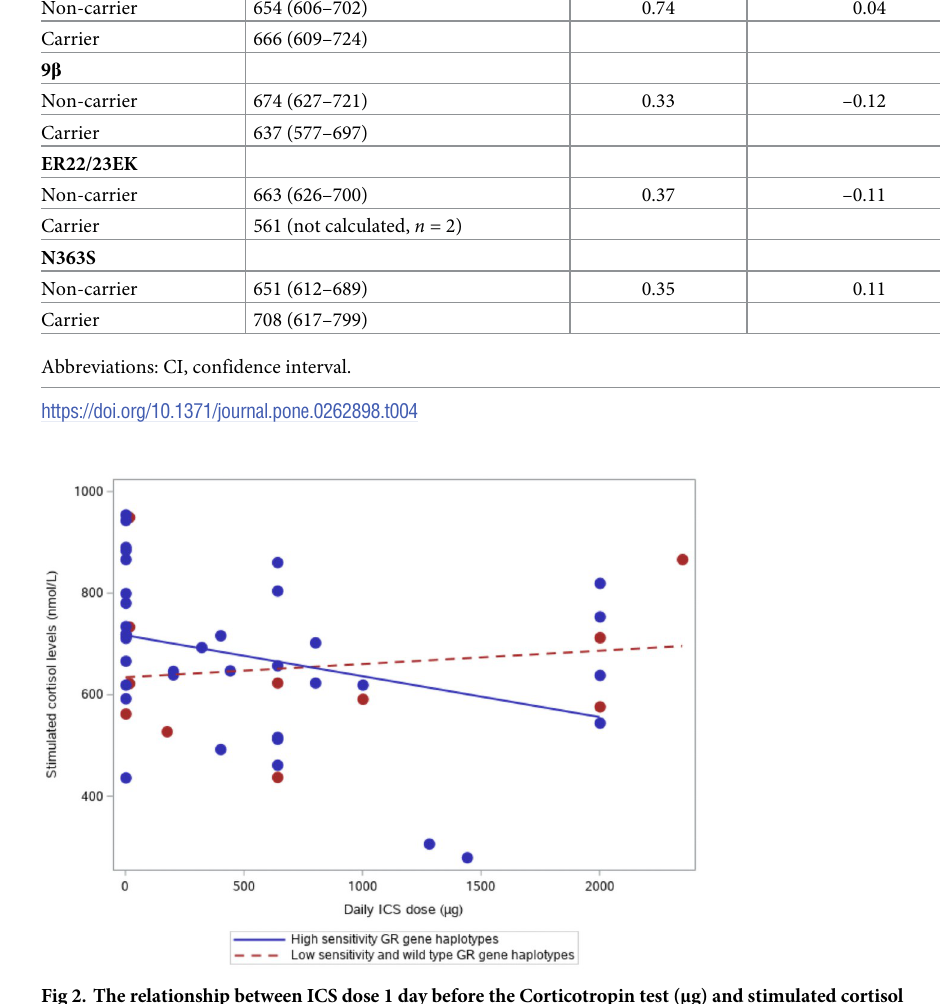
Fig 2. The relationship between ICS dose 1 day before the Corticotropin test ( μ g) and stimulated cortisol concentrations at baseline for the high-sensitivity glucocorticoid receptor gene haplotype group compared with the low-sensitivity and wild-type glucocorticoid receptor gene haplotype group. Abbreviations: ICS, inhaled corticosteroid; GR, glucocorticoid